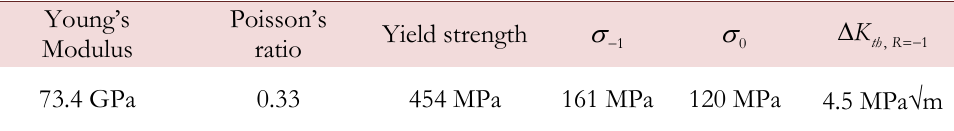
Table 1: Material properties of 7050-T7451 Al